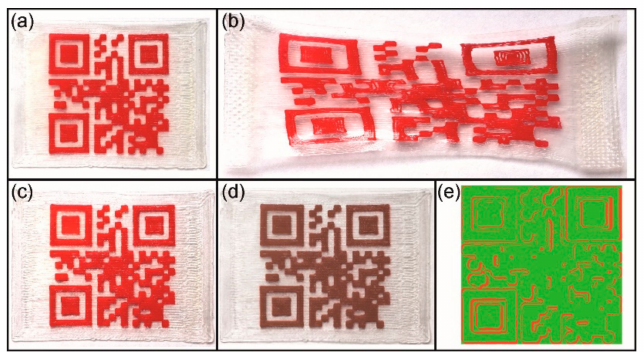
Figure 9. Type 2 QR code carrier: Permanent shape after 3D printing ( a ), temporary shape as obtained after programming ( F max = 5 N) ( b ), and recovered shape after heating to 60 ◦ C ( c ). To visualize shape recoverability, the image of the permanent shape was converted to black-and-white and superimposed with a transparency of 60% on the image of the recovered shape ( d ). The result of a mathematical calculation comparing the permanent shape with the recovered shape: congruent areas (green color) and incongruent areas (red color) ( e